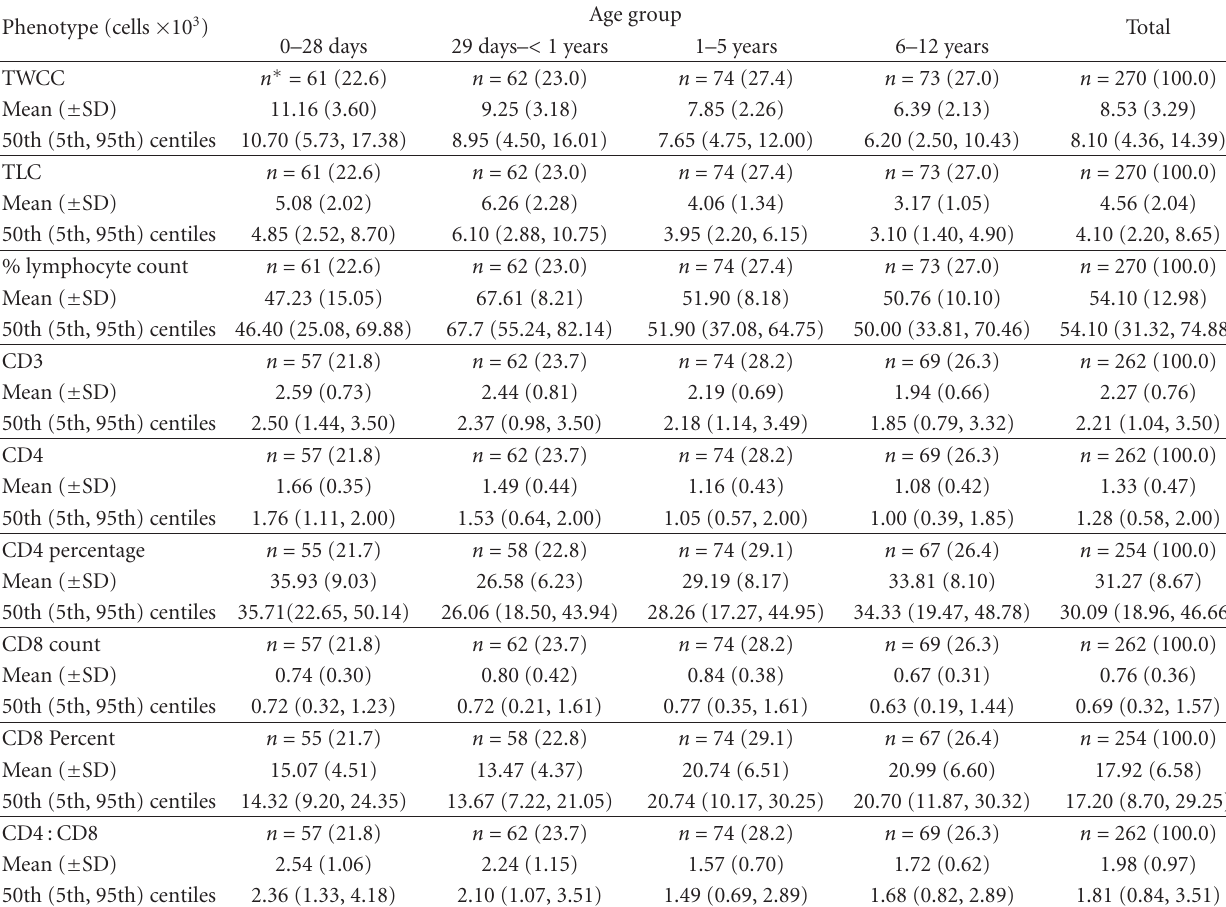
Table 1: Total white cell count, total lymphocytes count, subsets, and percentages for healthy children by age